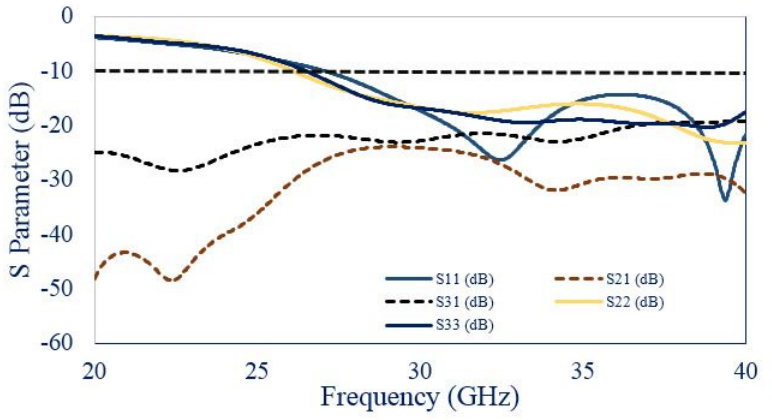
Figure 4. S-Parameters of three-element MIMO Antenna.